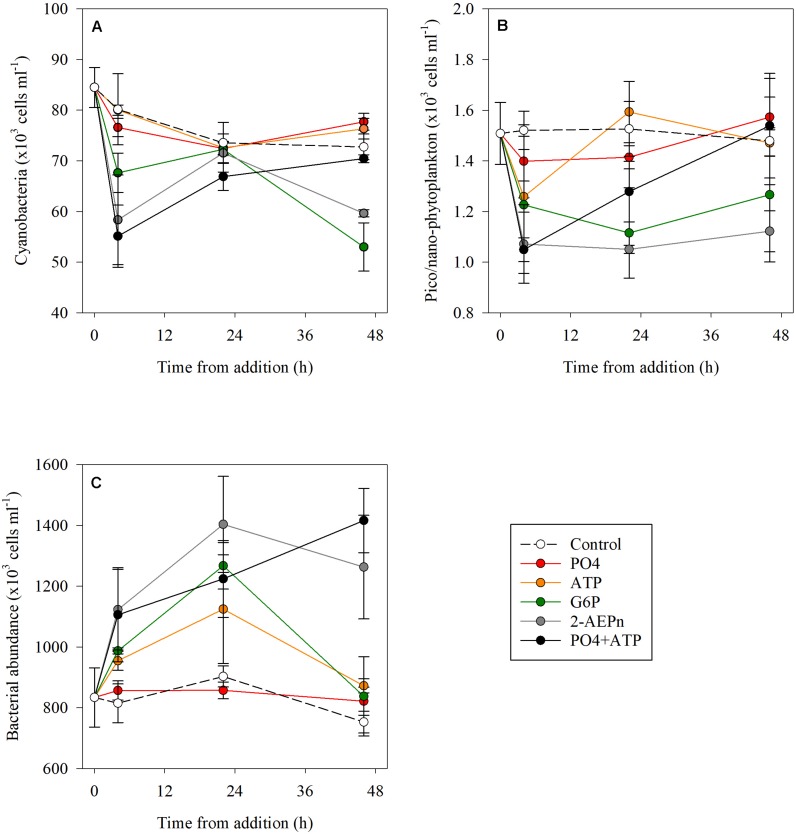
Temporal dynamics of cyanobacterial abundance (A), pico- and nano-eukaryote abundance (B), and heterotrophic bacterial abundance (C) following the addition of PO4 (red), ATP (orange), G6P (green), 2-AEPn (gray), PO4 + ATP (black), and un-amended controls (white). Values presented are the average and corresponding standard deviation (n = 3). Note the different Y axis.